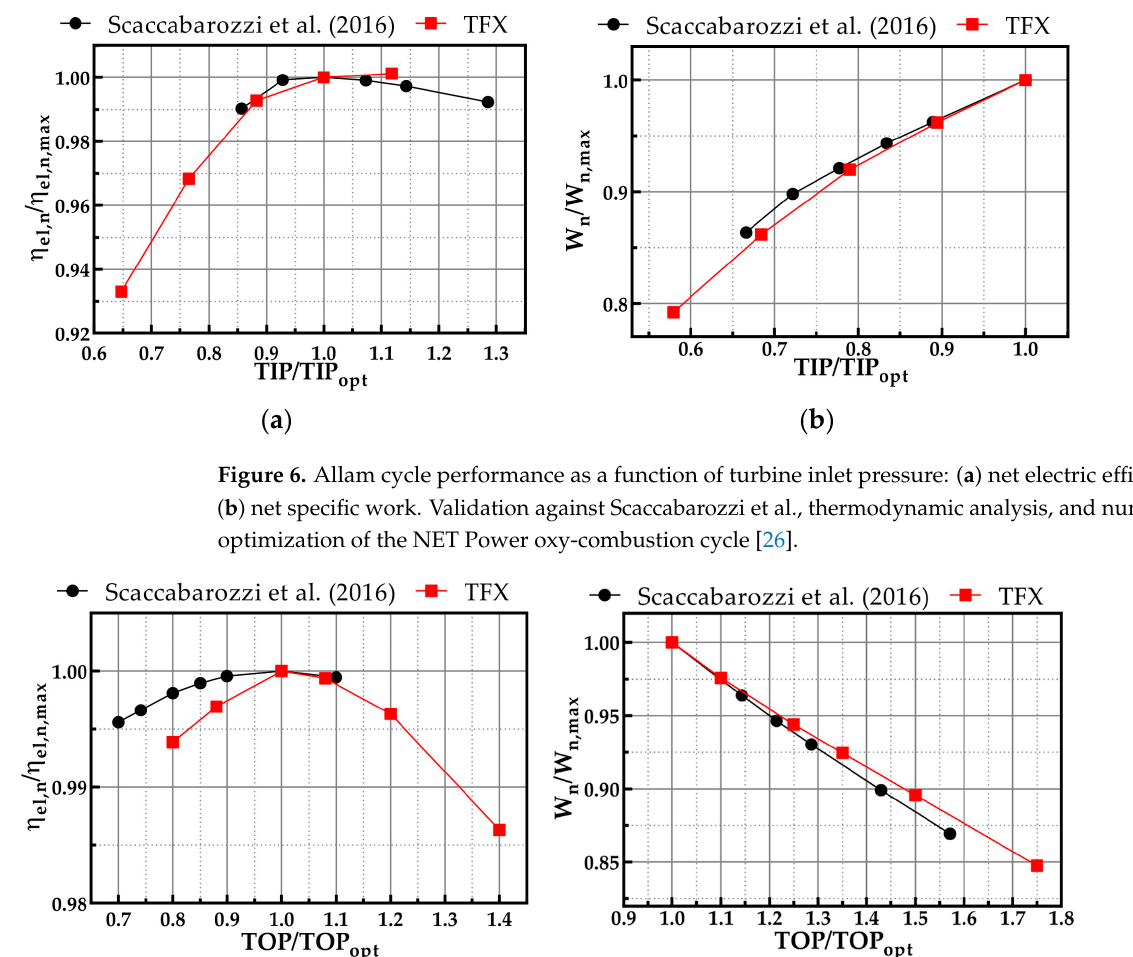
Figure 5. Allam cycle performance as a function of turbine inlet temperature: ( a ) net electric effi- ciency; ( b ) net specific work. Validation against Scaccabarozzi et al., thermodynamic analysis, and numerical optimization of the NET Power oxy-combustion cycle [26].